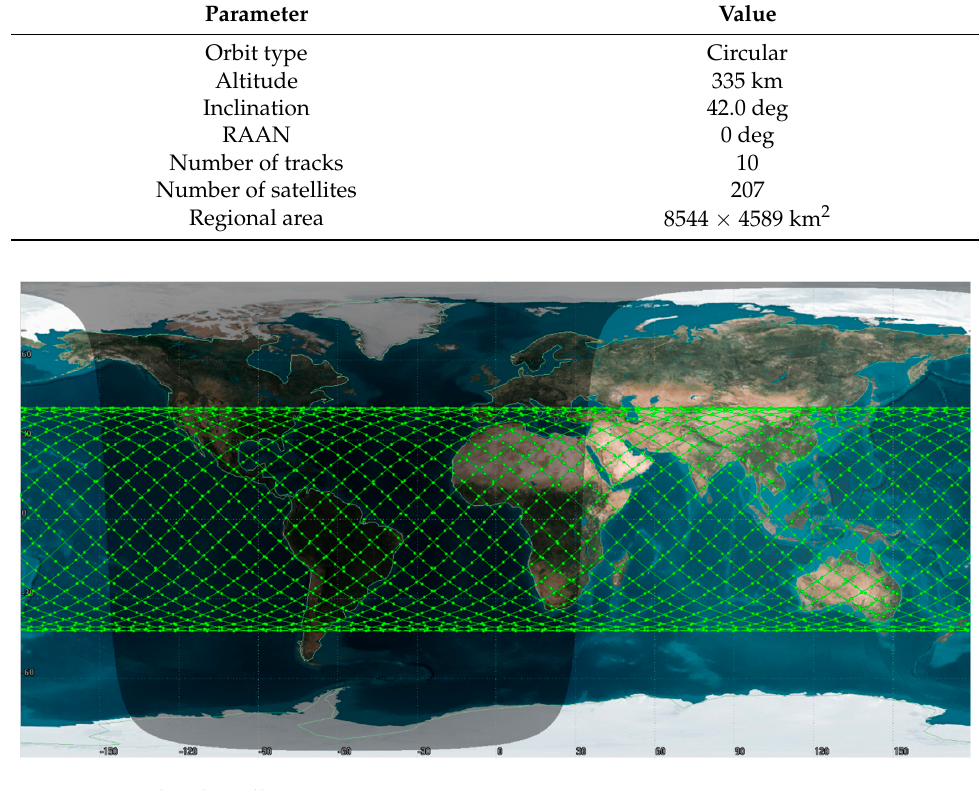
Figure 3. Simulated satellite 2D